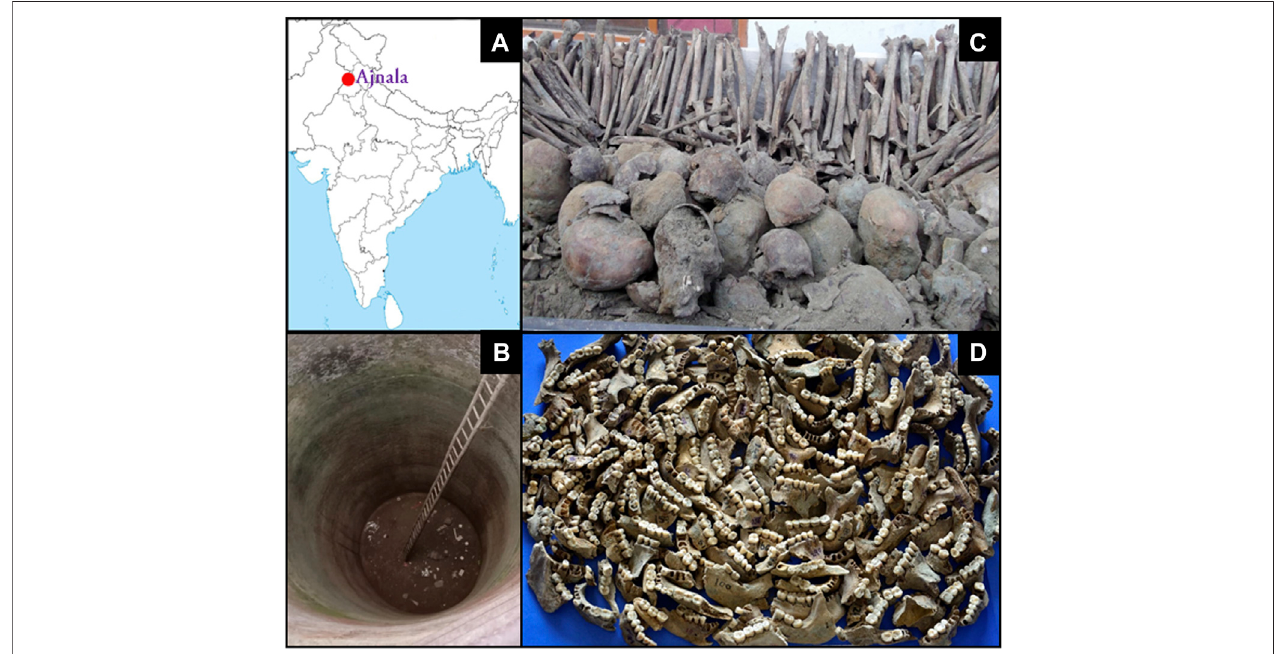
FIGURE1|(A) MapofIndiashowingstudysiteAjnala(redcircle)fromwhichthesepoy ’ sskeletalremainswereexcavated. (B) Abandoneddeepwellwherealarge number of skeletons were found. (C) Skulls and long bones collected from the abandoned well. (D) Mandibles with attached tooth samples.